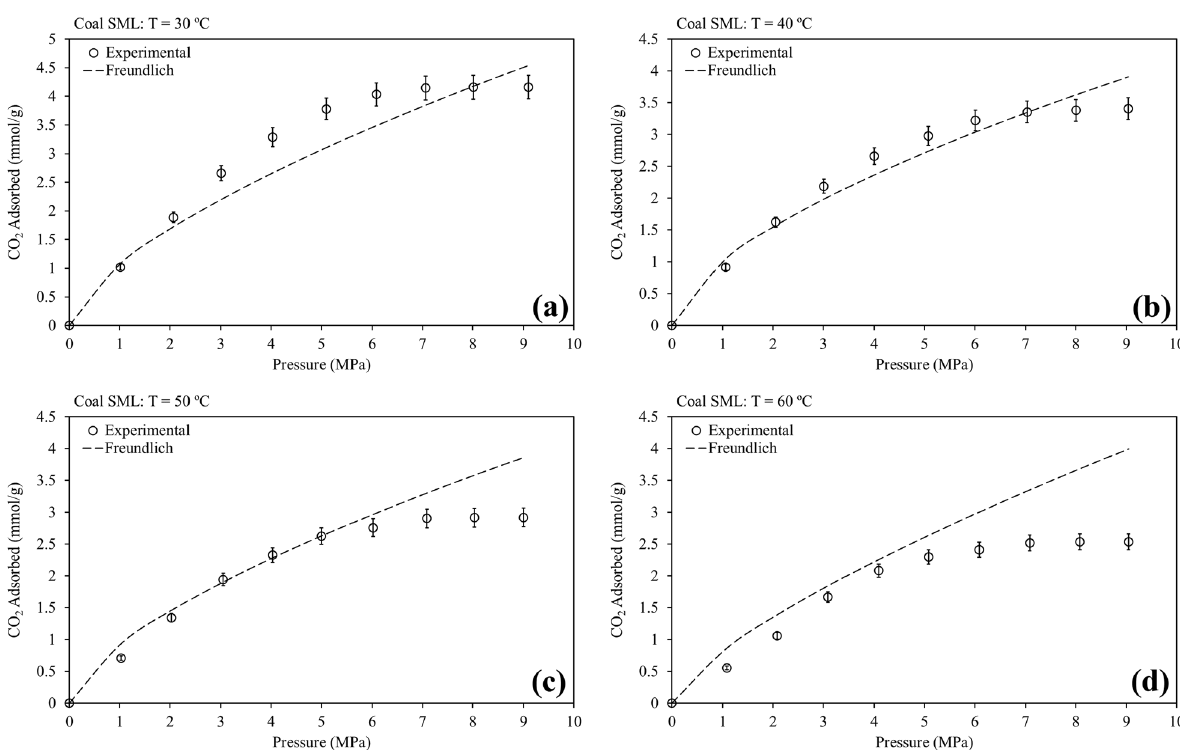
Fig. 4 Freundlich isotherm model fit for pure CO 2 sorption on Coal SML at a 30 ºC, b 40 ºC, c 50 ºC, and d 60